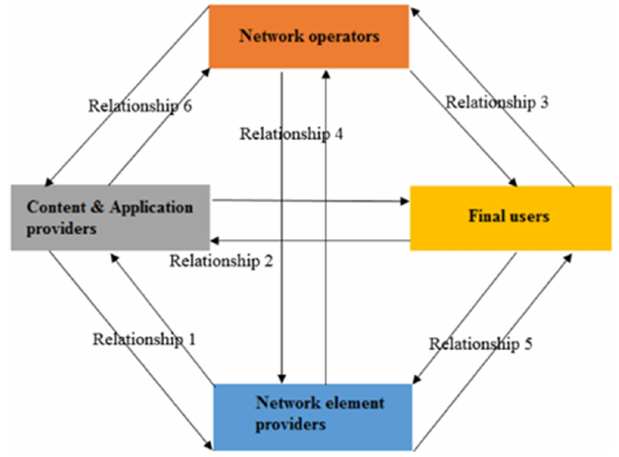
Fig. 2. Symbiotic relationships with the four-layer